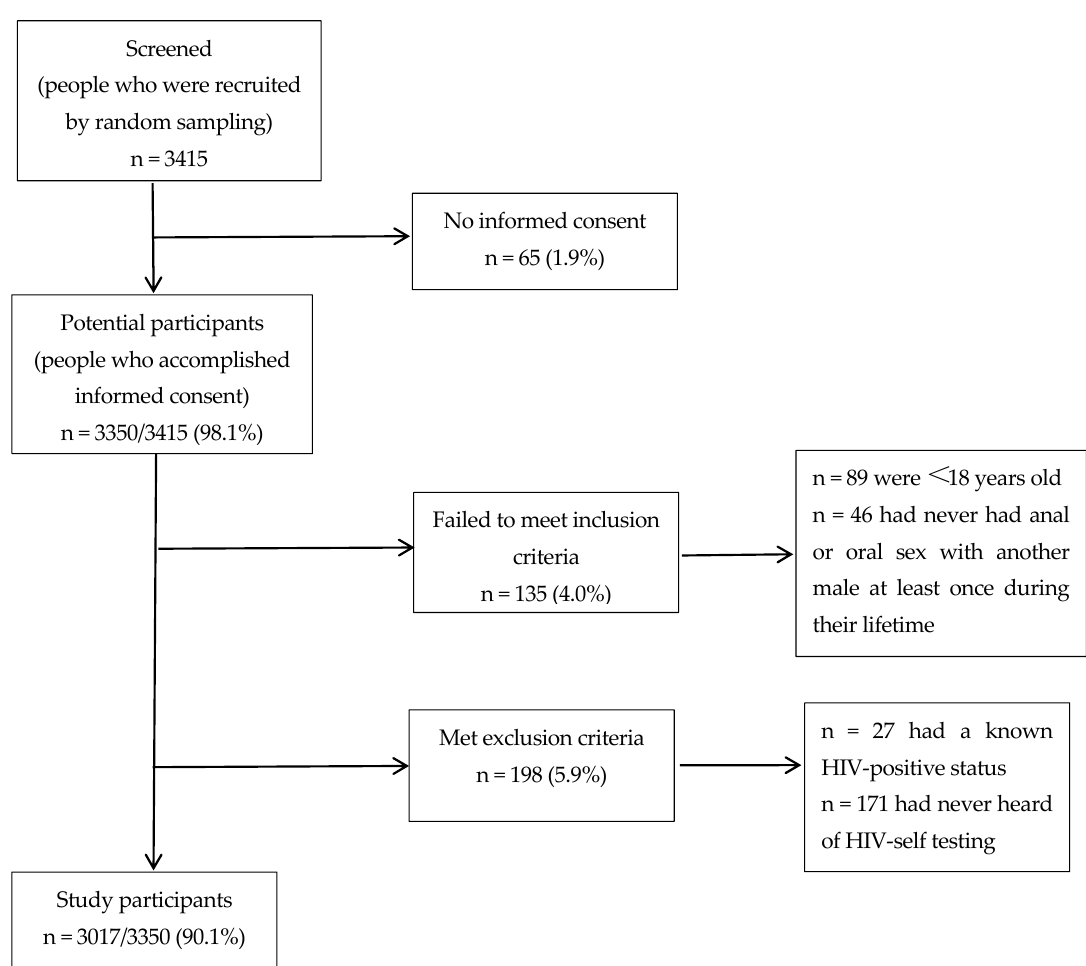
Figure 1. Flowdiagramshowingthestudydesign, Figure 1. Flow diagram showing the study design, as well as the development of the final study population.